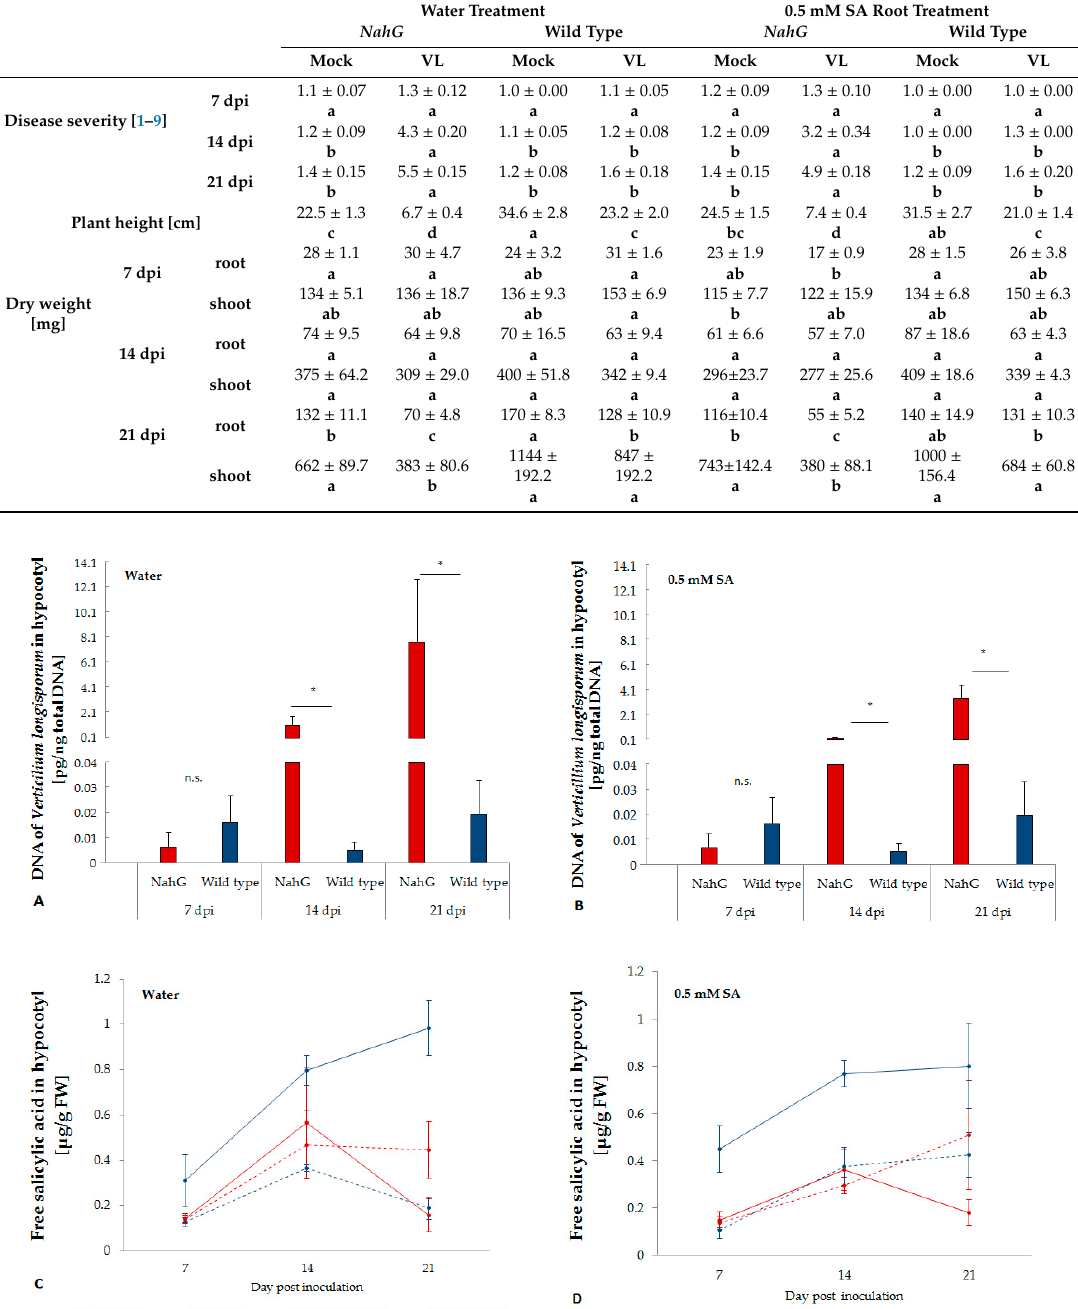
Figure 1. Colonization of in B. napus cv. Drakkar and its NahG transformant with V. longisporum with ( A ) or without ( B ) exogenous application of salicylic acid and the endogenous free salicylic acid content in the hypocotyl after infection ( C , D ). Bars indicate standard errors. Mean data were obtained from four biological replications. Asterisks on the bars indicate significant di ff erences between two genotypes at the same time point (LSD, p <